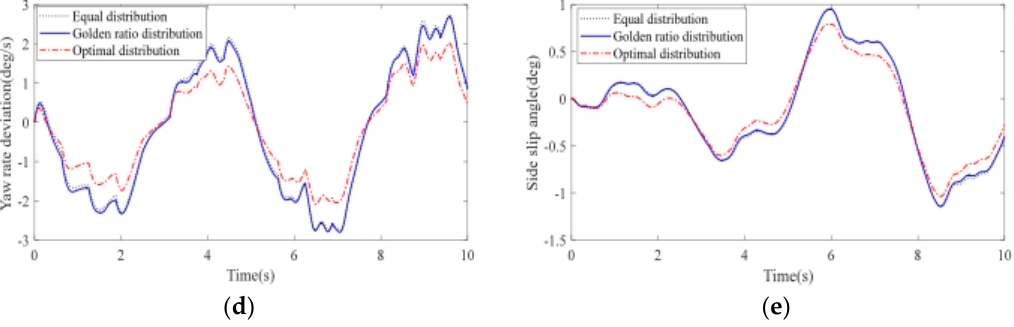
Figure 6. Simulation results of the sine wave steering conditions: ( a ) Vx ; ( b ) optimized motor torque after distribution; ( c ) efficiency; ( d ) yaw rate deviation; ( e ) slip angle deviation.